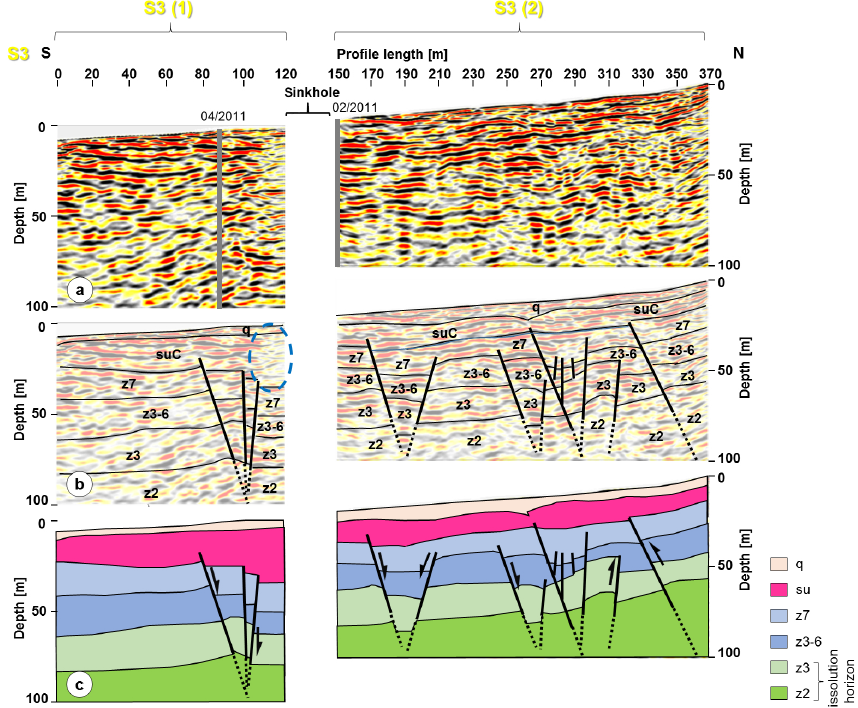
Figure 8. Uninterpreted reflection-seismic profile S3 (a) with stratigraphy derived from the 04/2011 and 02/2011 boreholes (b) and with interpretation (c) . The stratigraphic units are explained in Fig. 3. The profile was surveyed from south to north across the sinkhole area, leaving out the sinkhole itself. Just as in profiles S1 and S2, steep normal and reverse faults can be seen, but no bowl-shaped structure is present. Instead the southern sinkhole margin is visible as a transparent area (blue dashed circle), with near-surface reflectors dipping towards the